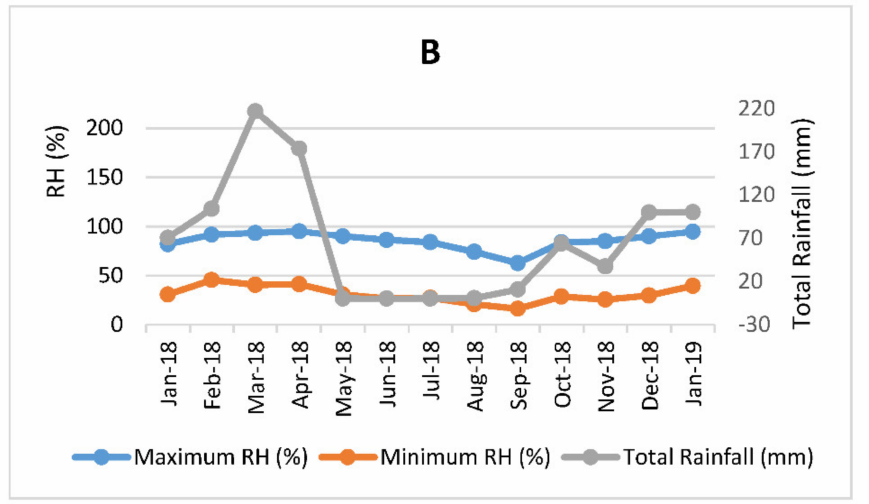
Figure 3. Climatic conditions during the harvesting period-temperature ( A ), relative humidity (RH), and total rainfall ( B ) measured at the University of Pretoria experimental farm in Pretoria, South